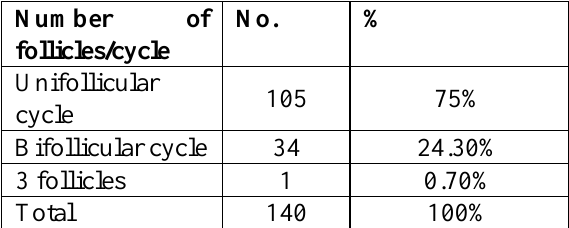
Table-4: Number of ovarian follicles observed in the gonadotrophin (r-FSH) cycles